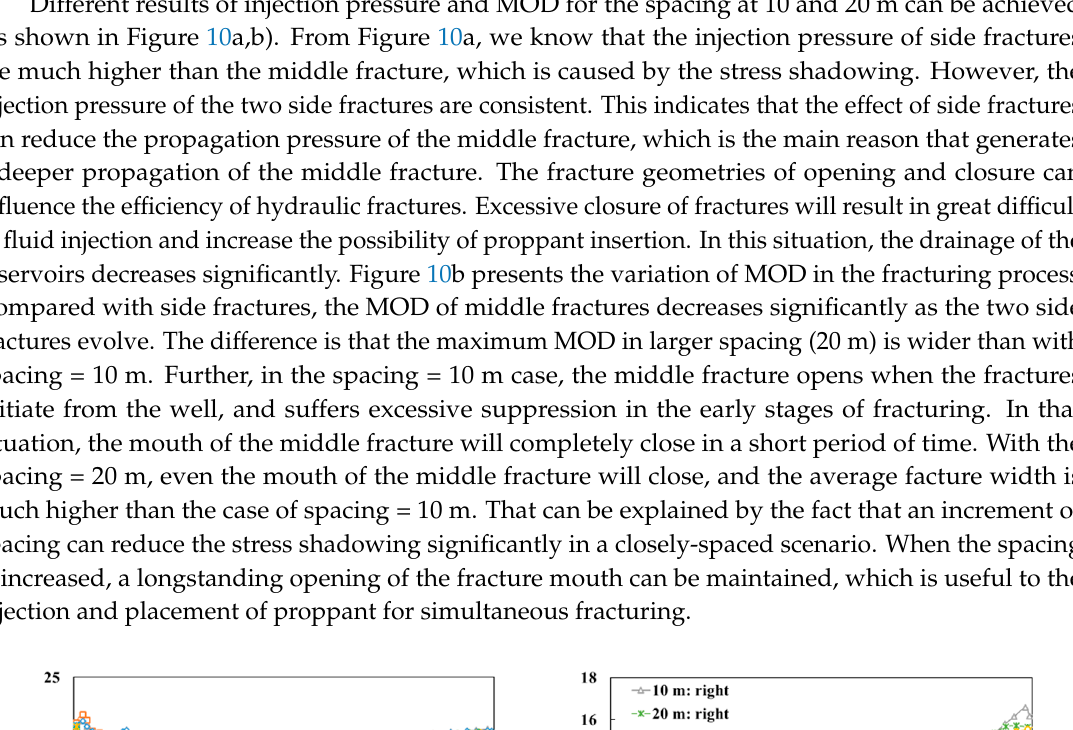
Figure 9. Fracture geometries of simultaneous fracturing with different closely-spacing (POR is the pore pressure: Pa): ( a ) Fracture geometries of spacing = 10 m; ( b ) Fracture geometries of spacing = 20 m.